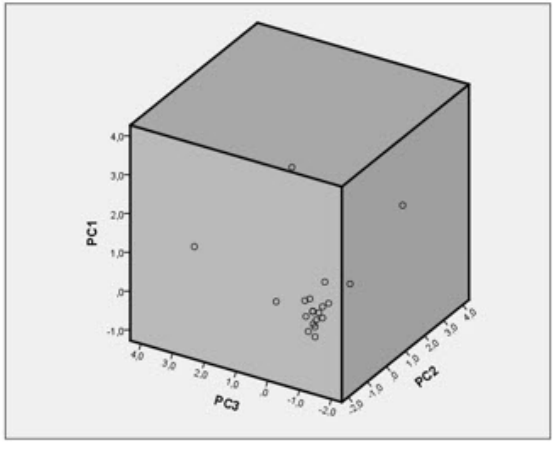
Figure 5. The 20 experimental texts, 3